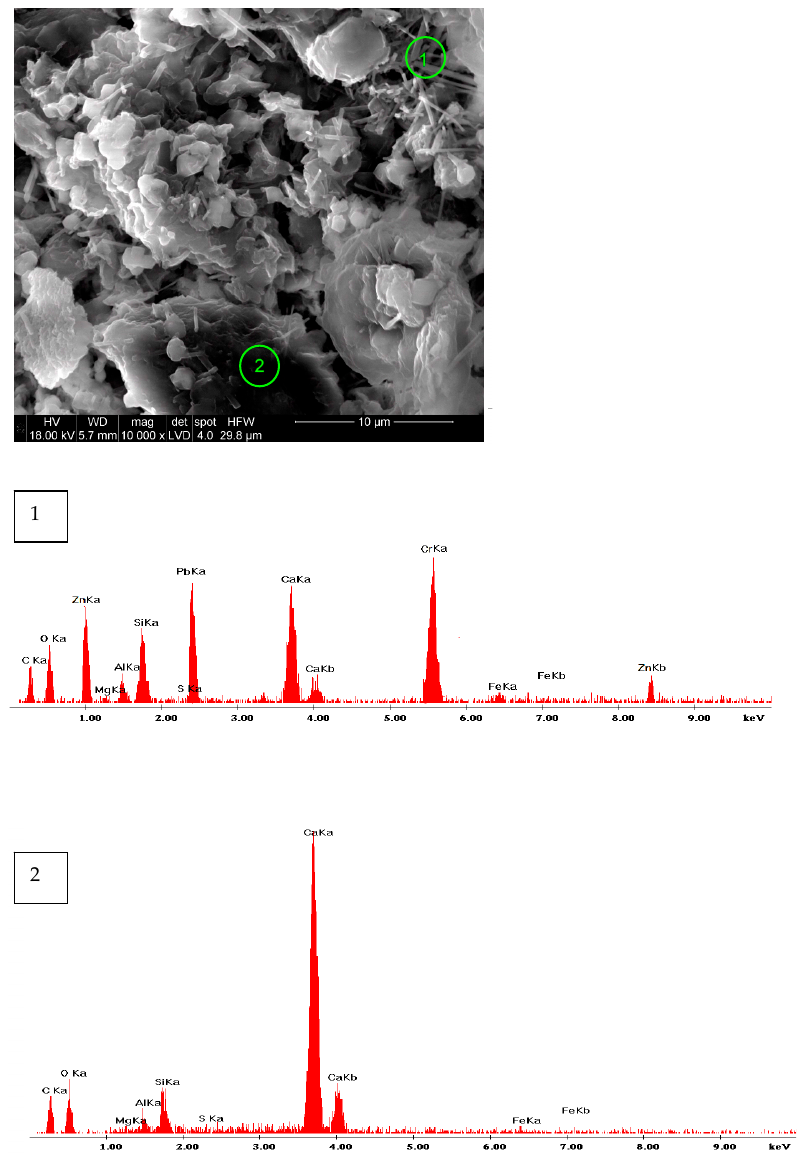
Figure 13. SEM and EDS analysis of the sample based on smectite clay [17]. Table 3. Aliphatic hydrocarbon contents before and after the filtration process.